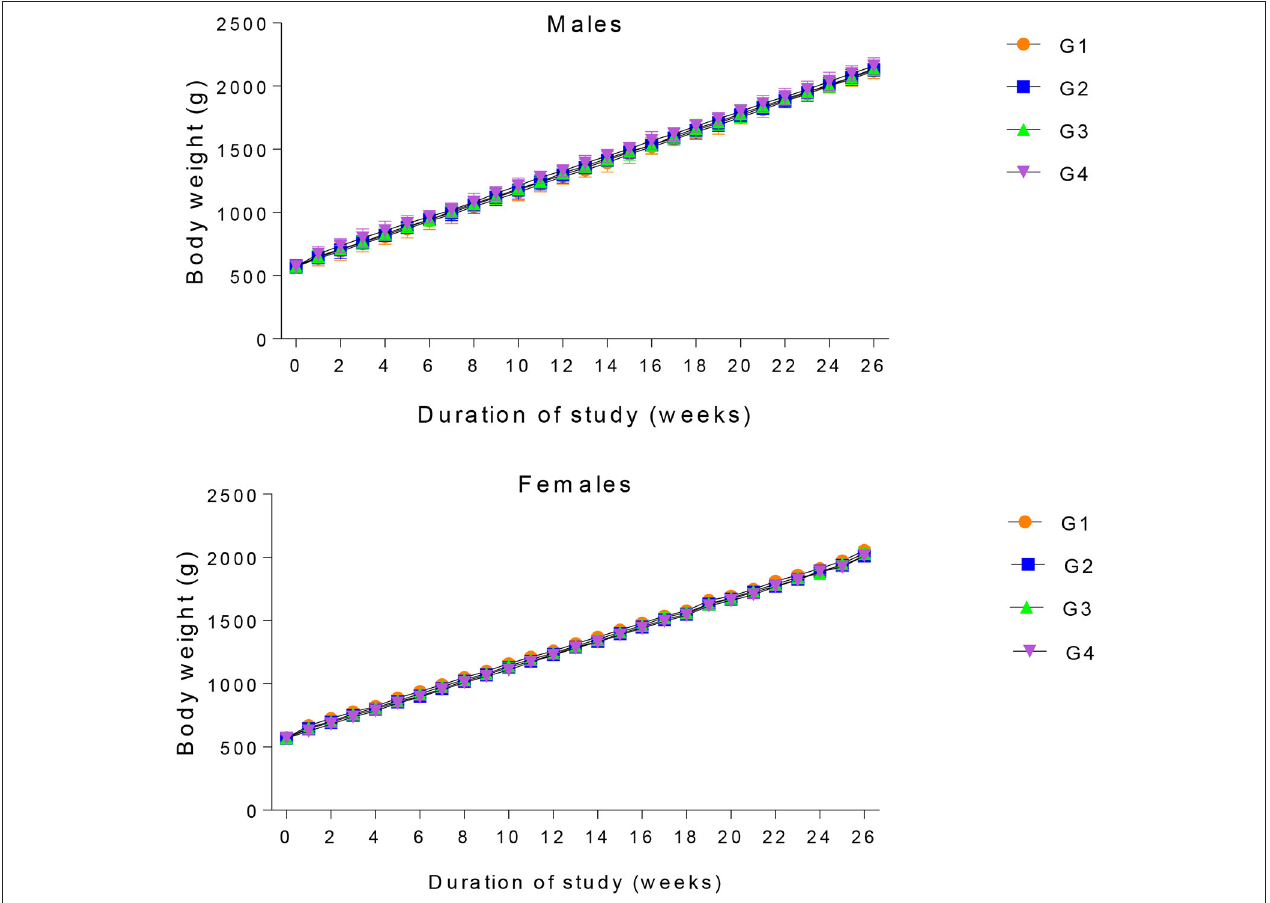
FIGURE 2 | Mean weekly body weight of male and female rabbits throughout the growth phase. G1 represent the Control group. G2, G3, and G4 represent 20, 30, and 40% GM cotton